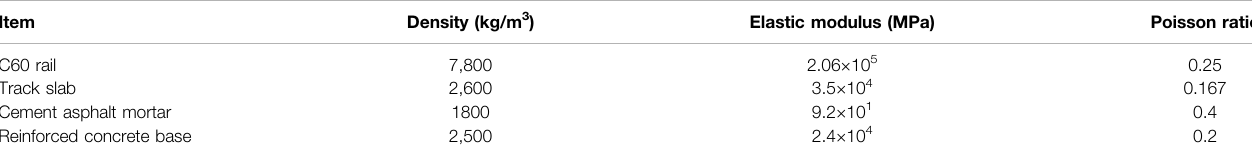
TABLE 4 | Parameters of the slab track.